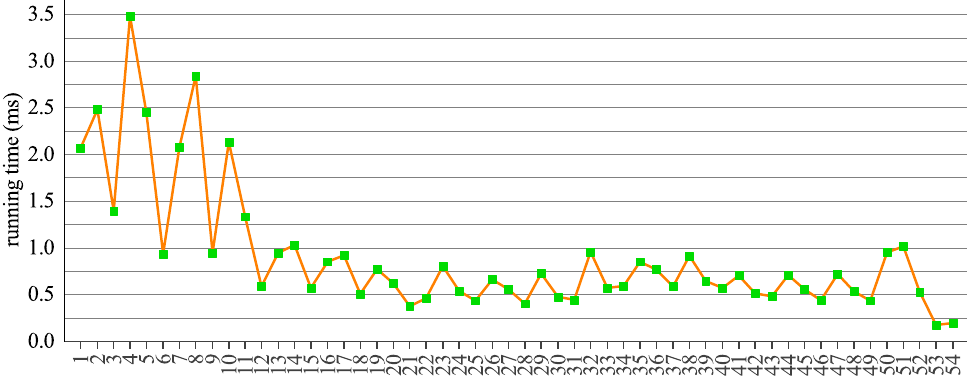
Figure 13. CPU running time of each layer.